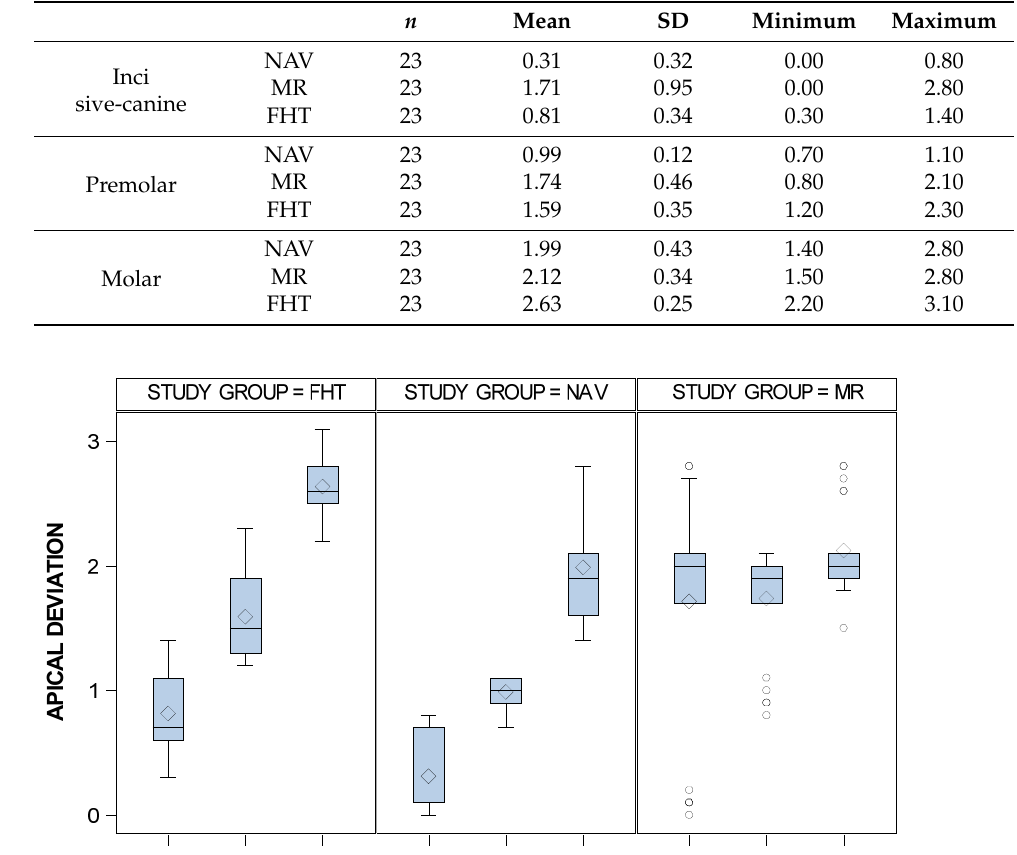
Table 4. Descriptive deviation values at apical end-point (mm) of the orthodontic micro-screws placed by using conventional freehand technique, mixed reality technique and computer-aided static navigation technique study groups in the incisive-canine, premolar and molar dental sector.